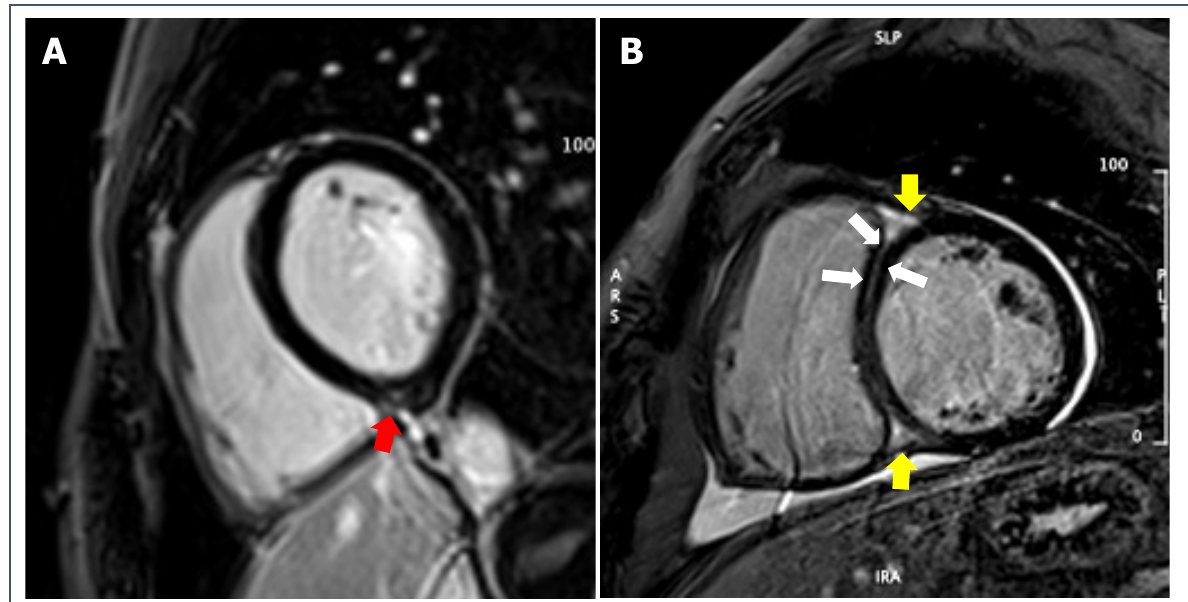
Figure 5. LGE short-axis sequences of a 28-year-old male endurance athlete with athlete’s hearts ( A ) and of a 34-year-old male patient with DCM ( B ). In the first case, mild LGE signal is seen in the inferior RVIP (red arrow). In ( B ), a thin LGE stria can be appreciated in the interventricular (IV) septum (white arrows), and a more pronounced LGE storage is visible in the anterior and inferior RVIP (yellow arrows).